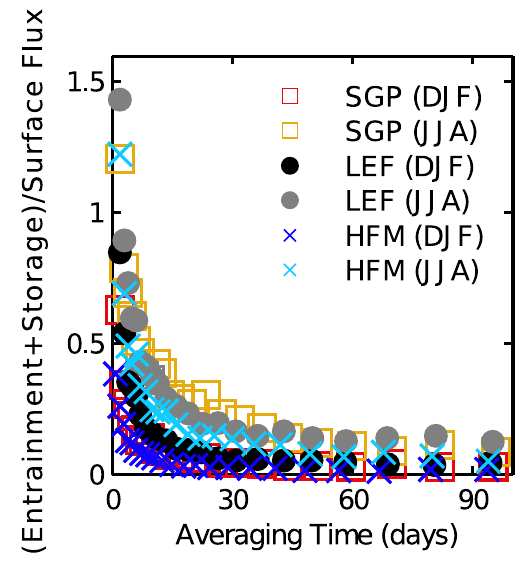
Fig. 1. Ratios of the sum of entrainment and storage to net sur- face flux, for various averaging times between 1 and 90-days dur- ing June, July, August (JJA) and December, January, and February (DJF). Ratios were calculated using the CT/TM5 model output at all three sites (SGP, LEF, HFM), combined with meteorological data from ECMWF (see text for